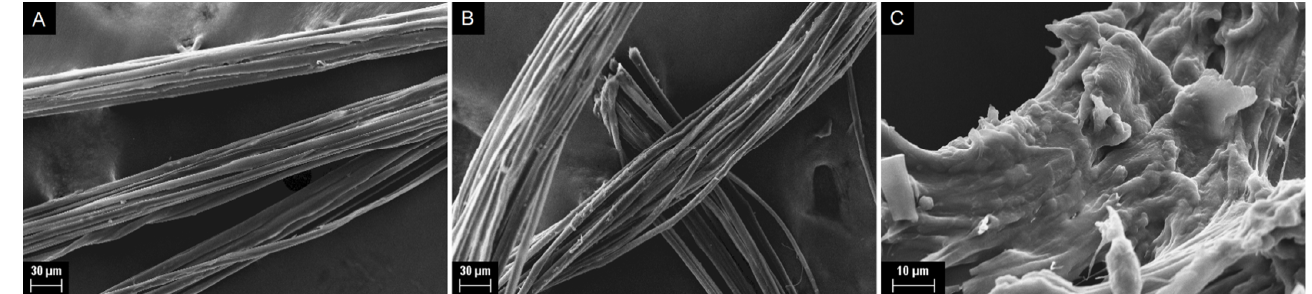
Figure 5. SEM micrographs of silk as received ( A ), after additional degumming ( B ), and that dissolved in 1-butyl-3-methylimidazolium acetate and then regenerated in water ( C ). The micrograph scales are 30 μ m (parts ( A ) and ( B )) and 10 μ m (part ( C )).